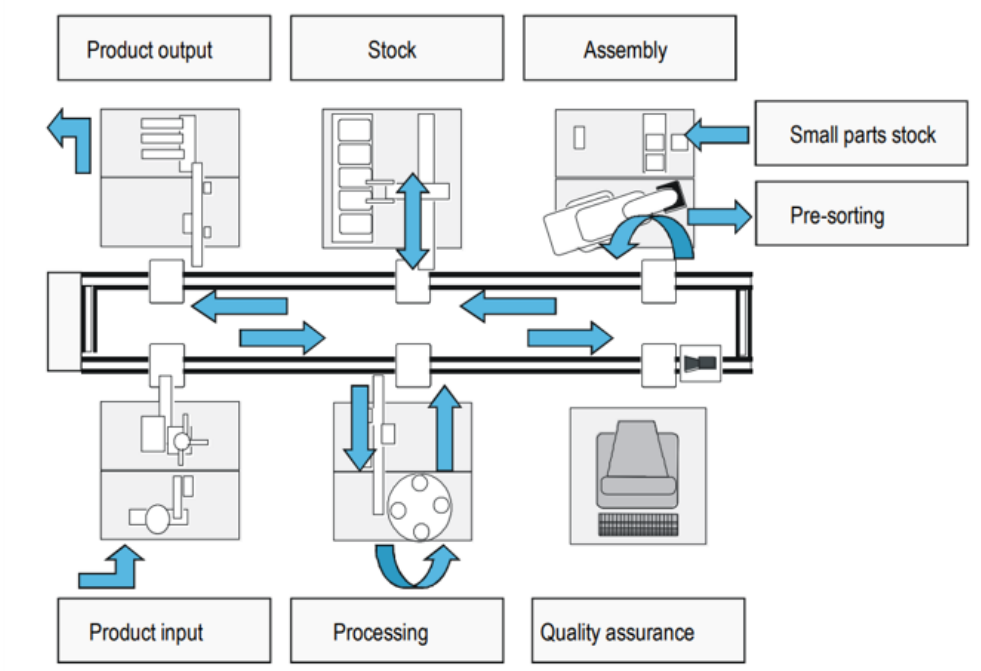
Figure 19. Flexible Manufacturing System (FMS) featuring six modular stations from component in- put to internal processing, quality checking, robotic assembly, storage and final product output